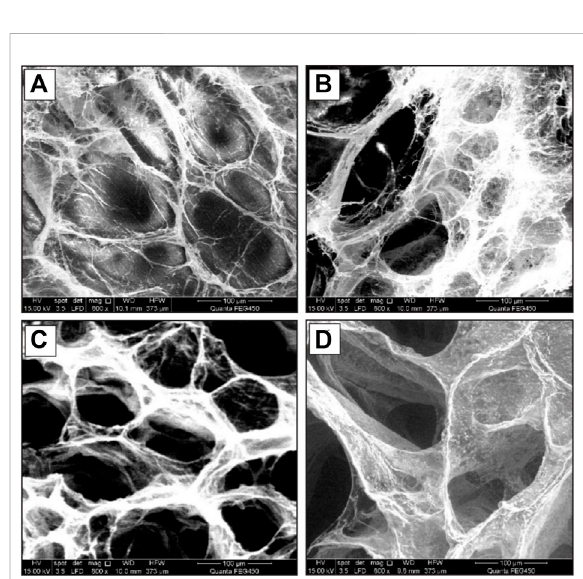
FIGURE 5 Micromorphology of pro fi lers with different polymer viscositiesbeforeandaftergelling. (A) 700 mg/L,before,Sample1; (B) 2500 mg/L,after,Sample1; (C) 700 mg/L,before,Sample2; (D) 2500 mg/L, after, Sample 2.